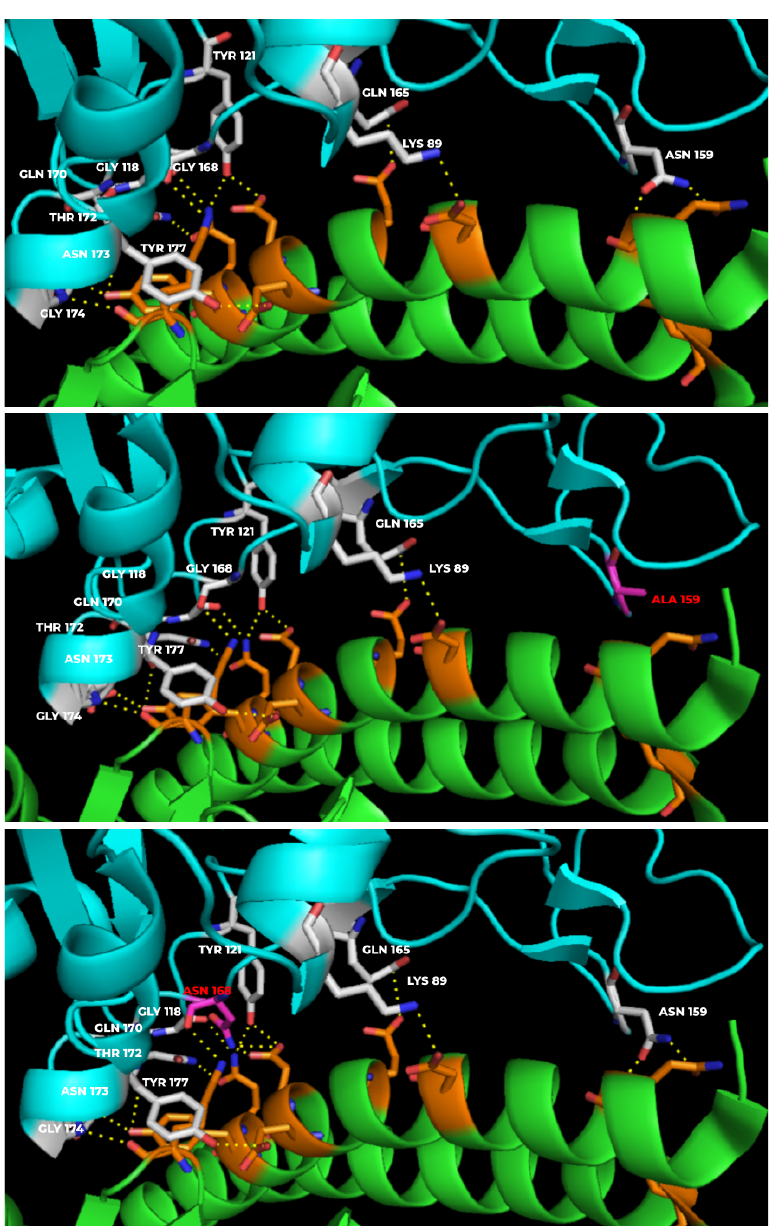
Figure 5. Hydrogen bonding pattern at the RBD-hACE-2r interface. The top panel shows a wild type interface with 13 hydrogen bonds while the middle and bottom panels show the interfaces of N159A (11 hydrogen bonds) and G168N (15 hydrogen bonds), respectively. The two mutant interfaces represent loss and gain of hydrogen bonds in the middle and bottom panels,